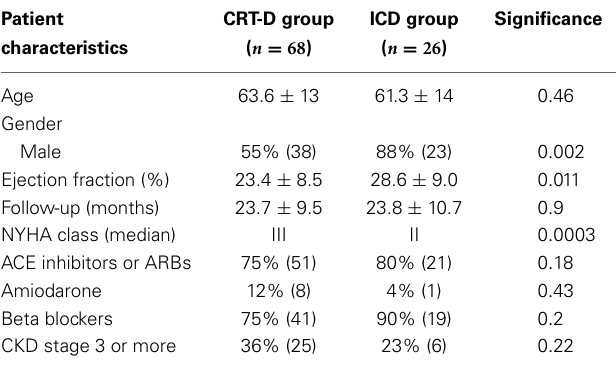
Table 3 | Non-ischemic cardiomyopathy—Patient characteristics.